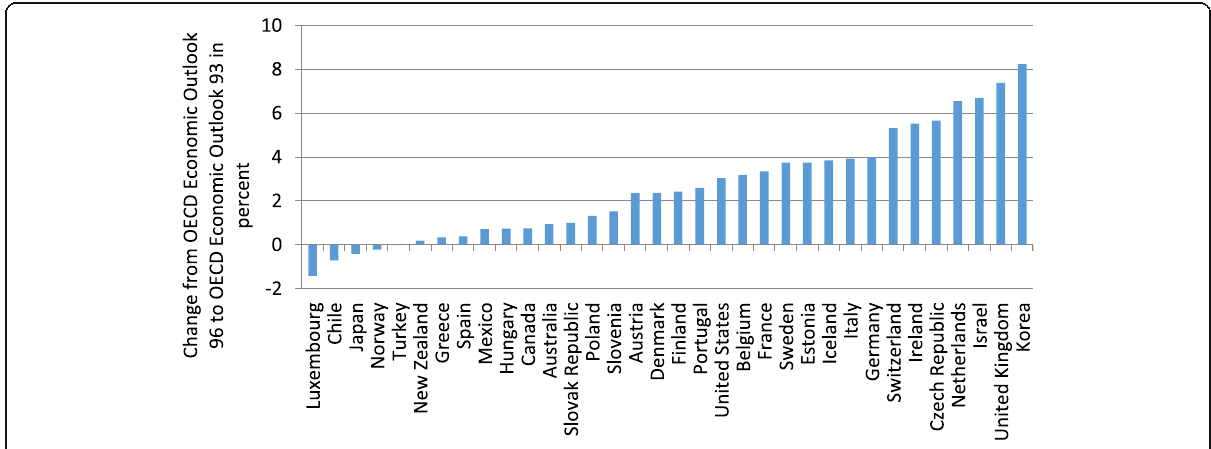
Fig. 10 Revisions of GDP. Year: 2012, Source: Authors ’ calculations, OECD (2013a), OECD